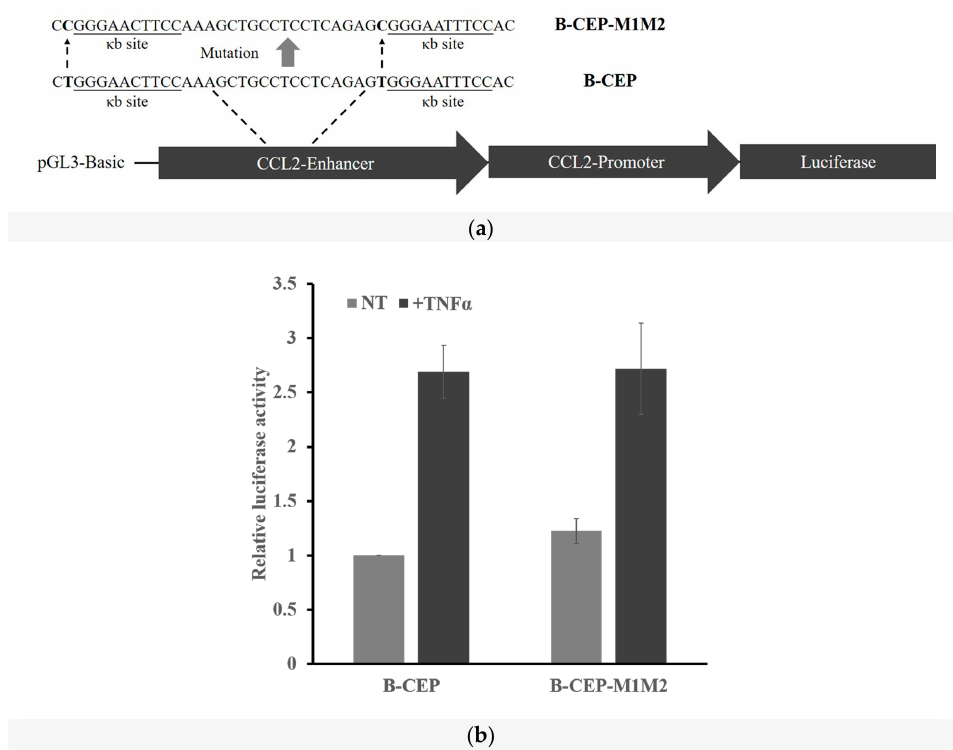
Figure 2. The -1C does not affect NF- κ B function. ( a ) Schematic maps of reporter constructs B-CEP and B-CEP-M1M2. The κ B site sequences were underlined. The T/C mutations were indicated with dotted arrows; ( b ) Luciferase activity of HEK 293T cells transfected with B-CEP or B-CEP-M1M2, respectively, with or without TNF α (10 ng/mL) stimulation for 18 h. NT, not treated. Data shown are means ± S.D. of results from three independent experiments.